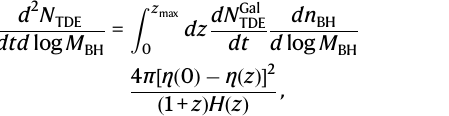
Fig.3|Per-galaxyTDEratesfordifferentSMBHspinmodels. Ratesareplottedas a function of the SMBH mass M BH . Solid black: TDE rates for SMBHs with spin a =0.998, which corresponds to the maximal value allowed by thin-disk spin-up. Dottedblack:ratesfornon-spinningBHs.Coloredlines:TDEratesassumingSMBHs